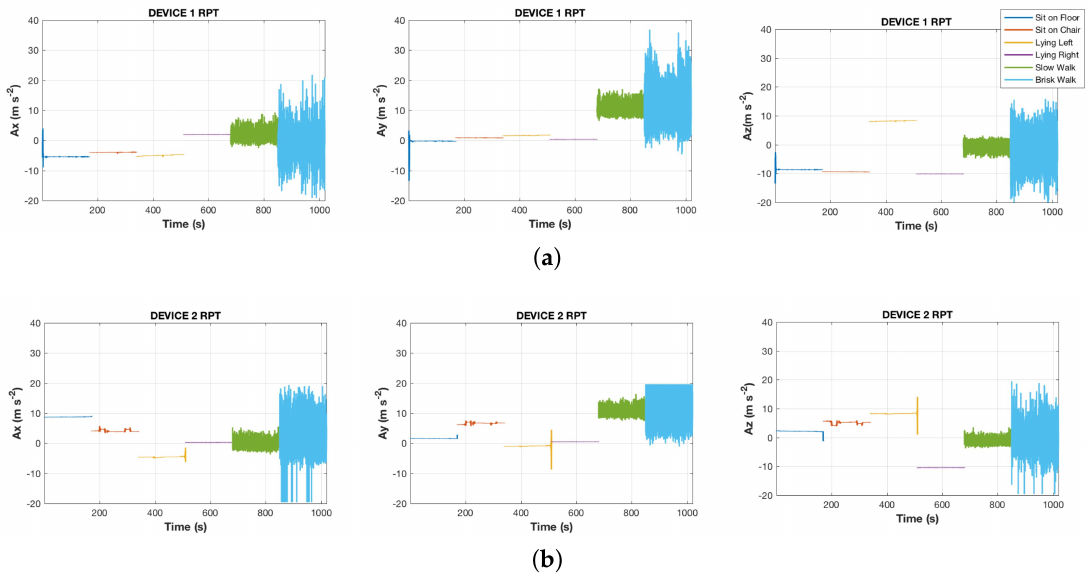
Figure 2. Raw accelerometer readings collected keeping devices in the Right Pants pockeT (RPT) for detailed activities ( a ) A x , A y and A z traces of Device 1 for different activities performed for 1000 s; ( b ) A x , A y and A z traces of Device 2 for different activities performed for 1000